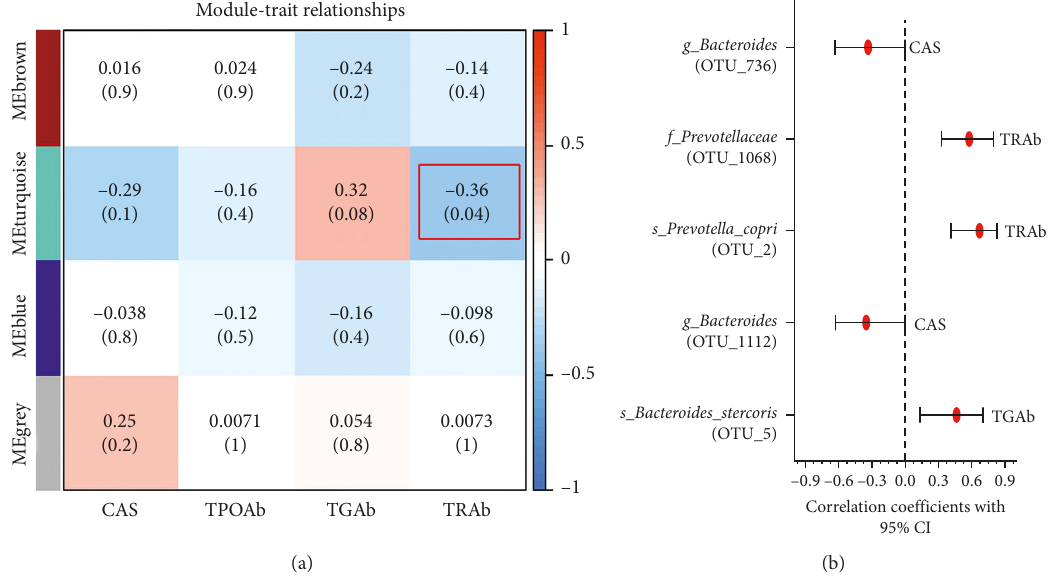
Figure 5: Association between the modules and GO-related traits. (a) Correlation analysis between four modules and GO-related traits. (b) Significant association between each of the bacteria involved in MEturquoise and GO-related traits. CI: confidence